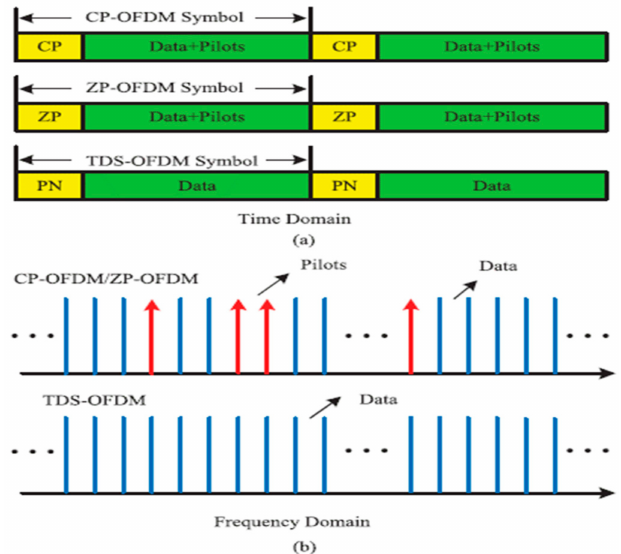
Figure 10. CP-OFDM, ZP-OFDM, and TDS-OFDM signal structure ( a ) time domain ( b ) frequency domain [94].